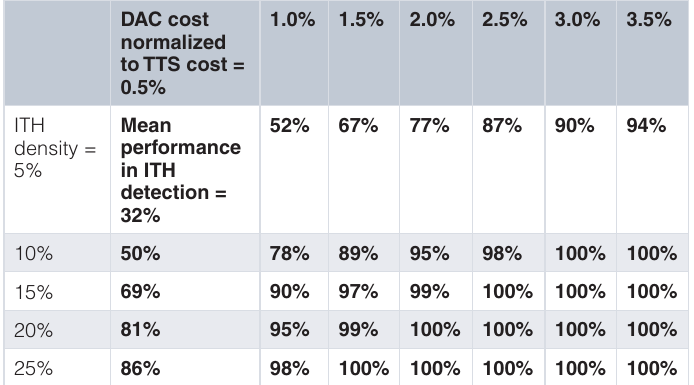
Table 1. Estimation for laboratory costs of DAC strategy (ITH